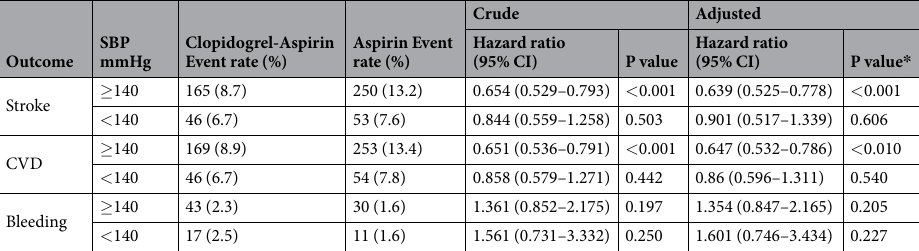
Table 2. Effects of dual and mono antiplatelet therapy on outcomes by SBP levels. * Adjusted for gender, age, body mass index, history of TIA or ischemic stroke, hypertension, hypercholesterolemia, diabetes mellitus, current or previous smoking, moderate to heavy drinking, qualifying event, antihypertensive drugs, lipid- lowering agent and antidiabetic agent. Abbreviations: CVD = combined vascular events (ischemic stroke, hemorrhagic stroke, myocardial infarction, or vascular death); SBP = systolic blood